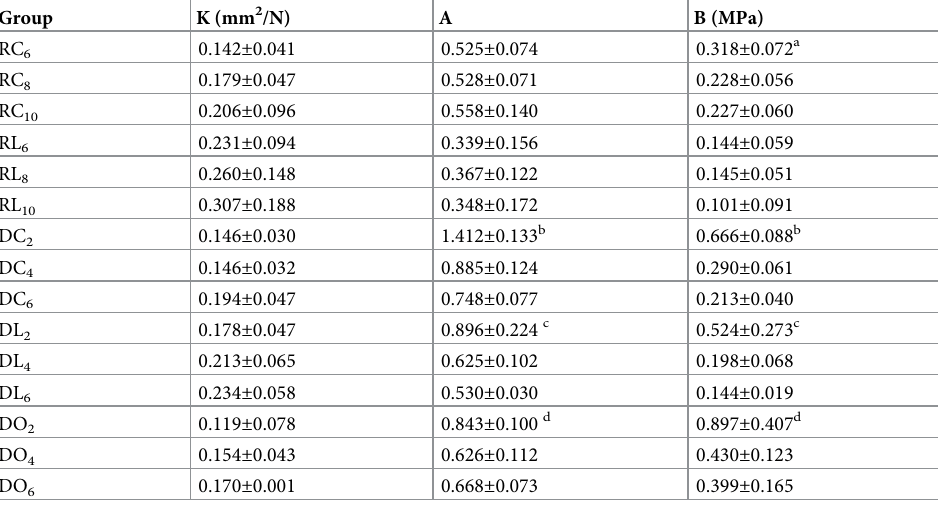
Table 3. Mean model parameters in the different